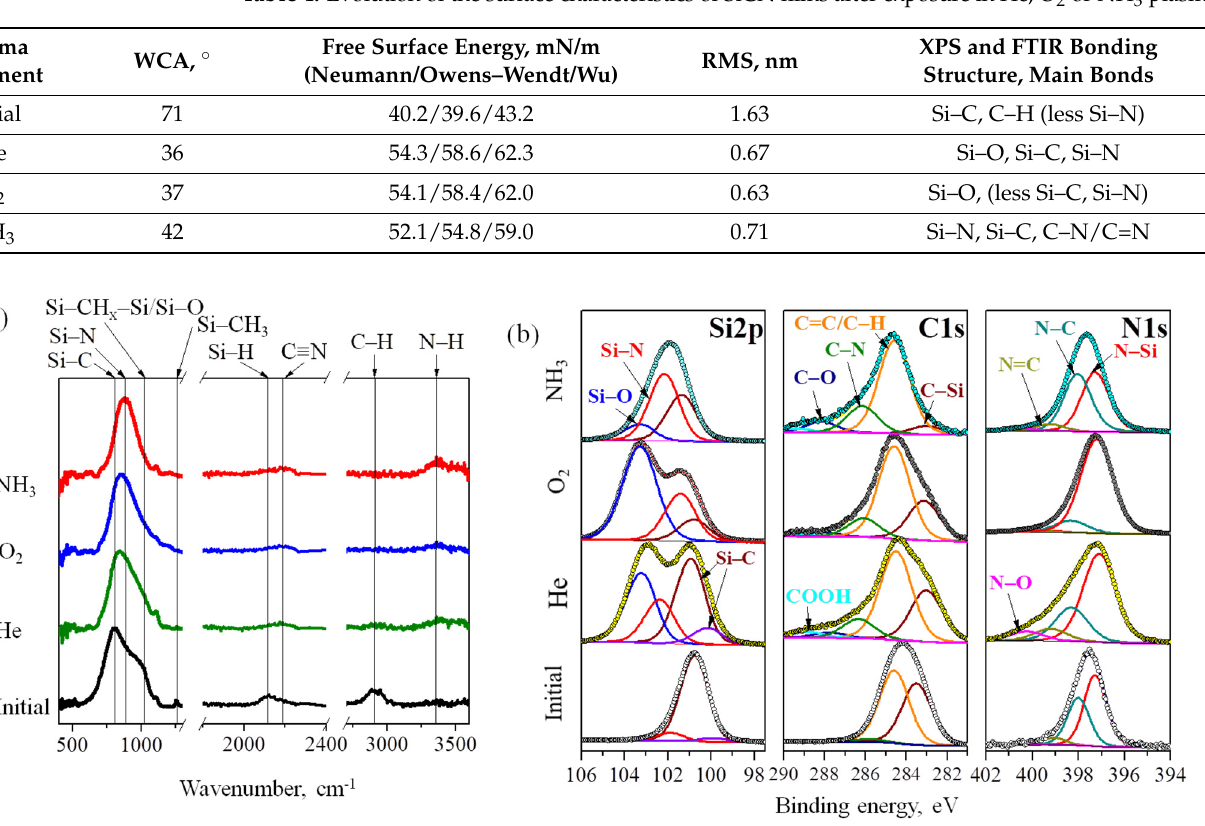
Table 4. Evolution of the surface characteristics of SiCN films after exposure in He, O 2 or NH 3 plasma.